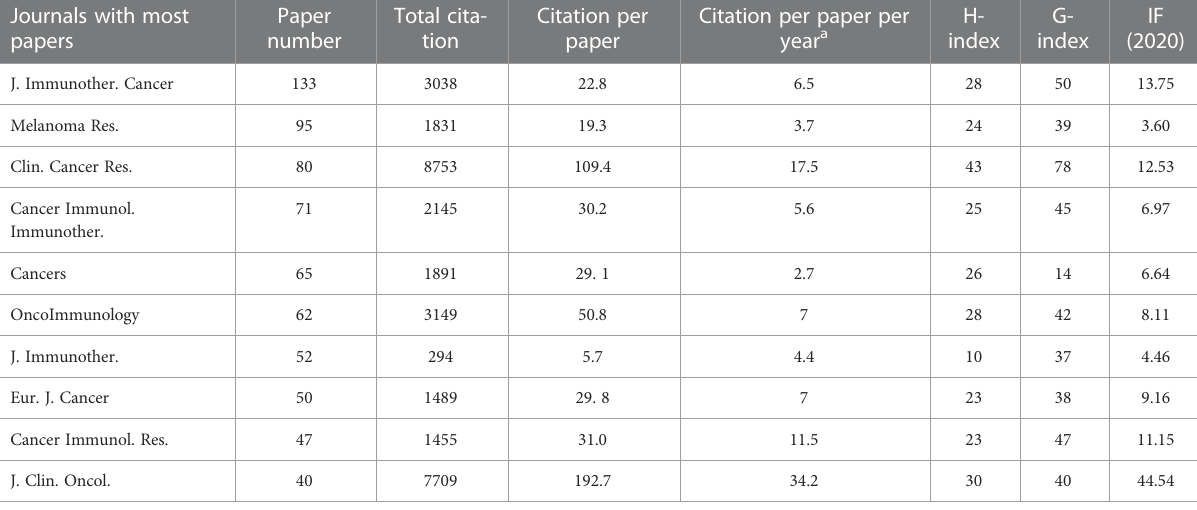
TABLE 2 The top 10 productive journals in melanoma immunotherapy between 2010 and